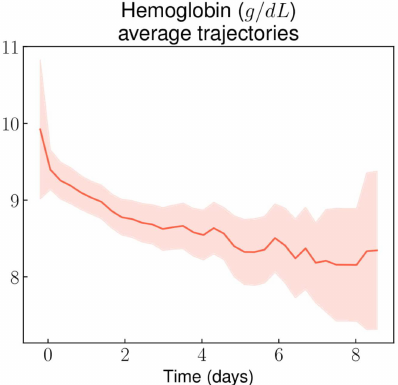
Figure 2. Hemoglobin average trajectory throughout non-complicated VOC-related hospital